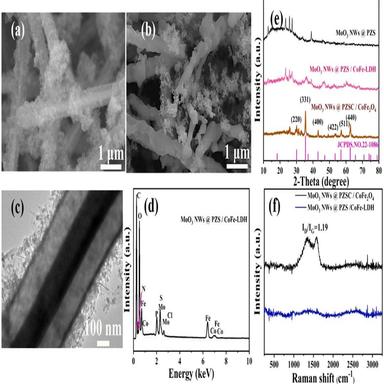
SEM of (a) MoO3 NWs @ PZS / CoFe-LDH and (b) MoO3 NWs @ PZSC / CoFe2O4. (c) TEM of MoO3 NWs @ PZS / CoFe-LDH. (d) EDS of MoO3 NWs @ PZSC / CoFe-LDH. (e) XRD of MoO3 NWs @ PZSC / CoFe2O4, MoO3 NWs @ PZS / CoFe-LDH and MoO3 NWs @ PZS. (f) Raman spectra of MoO3 NWs @ PZSC / CoFe2O4 and MoO3 NWs @ PZS / CoFe-LDH.